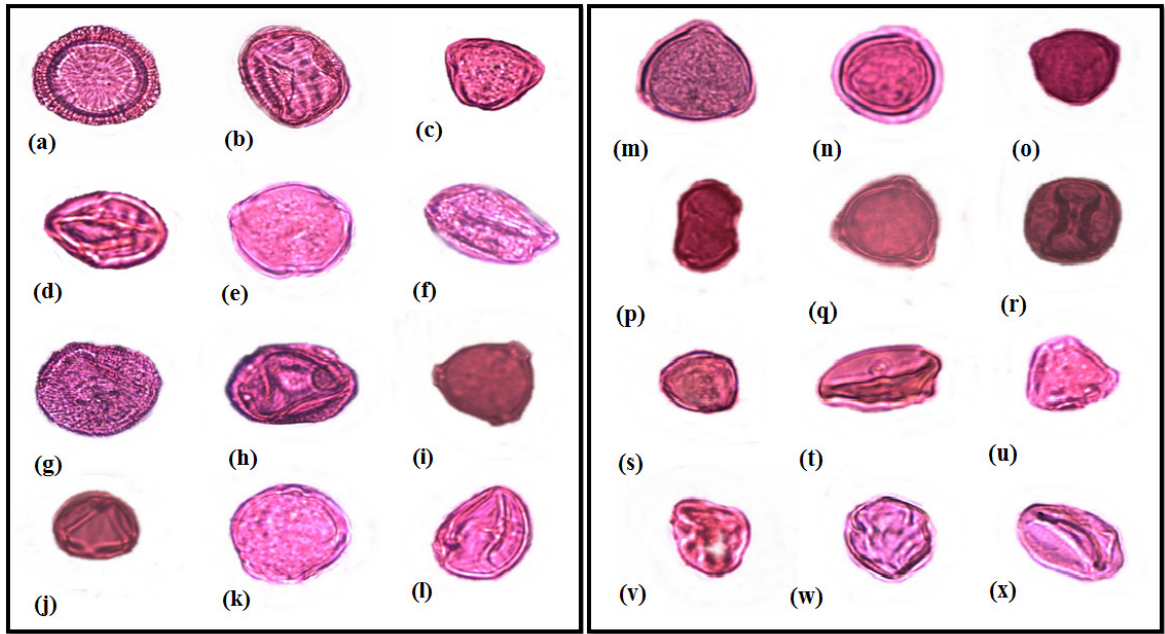
Figure 2. Light microscope photomicrographs of Solanaceae pollen grains. PV = polar view; EV =equatorial view (a) Brugmansia suaveolens (PV), (b) Brugmansia suaveolens (EV), (c) Capsicum annuum (PV) general view (d) Capsicum annuum (EV), (e) Cestrum parqui (PV), (f) Cestrum parqui (EV), (g) Datura innoxia (PV), (h) Datura innoxia (EV), (i) Solanum lycopersicum(PV), (j) Solanum lycopersicum (EV), (k) Physalis minima (PV), (l) Physalis minima (EV), (m) Solanum americanum (PV), (n) Solanum americanum (EV), (o) Solanum erianthum (PV), (p) Solanum erianthum (EV), (q) Solanum melongena (PV), (r) Solanum melongena (EV), (s) Solanum surattense (PV), (t) Solanum surattense (EV), (u) Withania somnifera (PV), (v) Withania somnifera (EV), (w) Nicotiana Plumbaginigolia (PV), (x) Petunia× alba